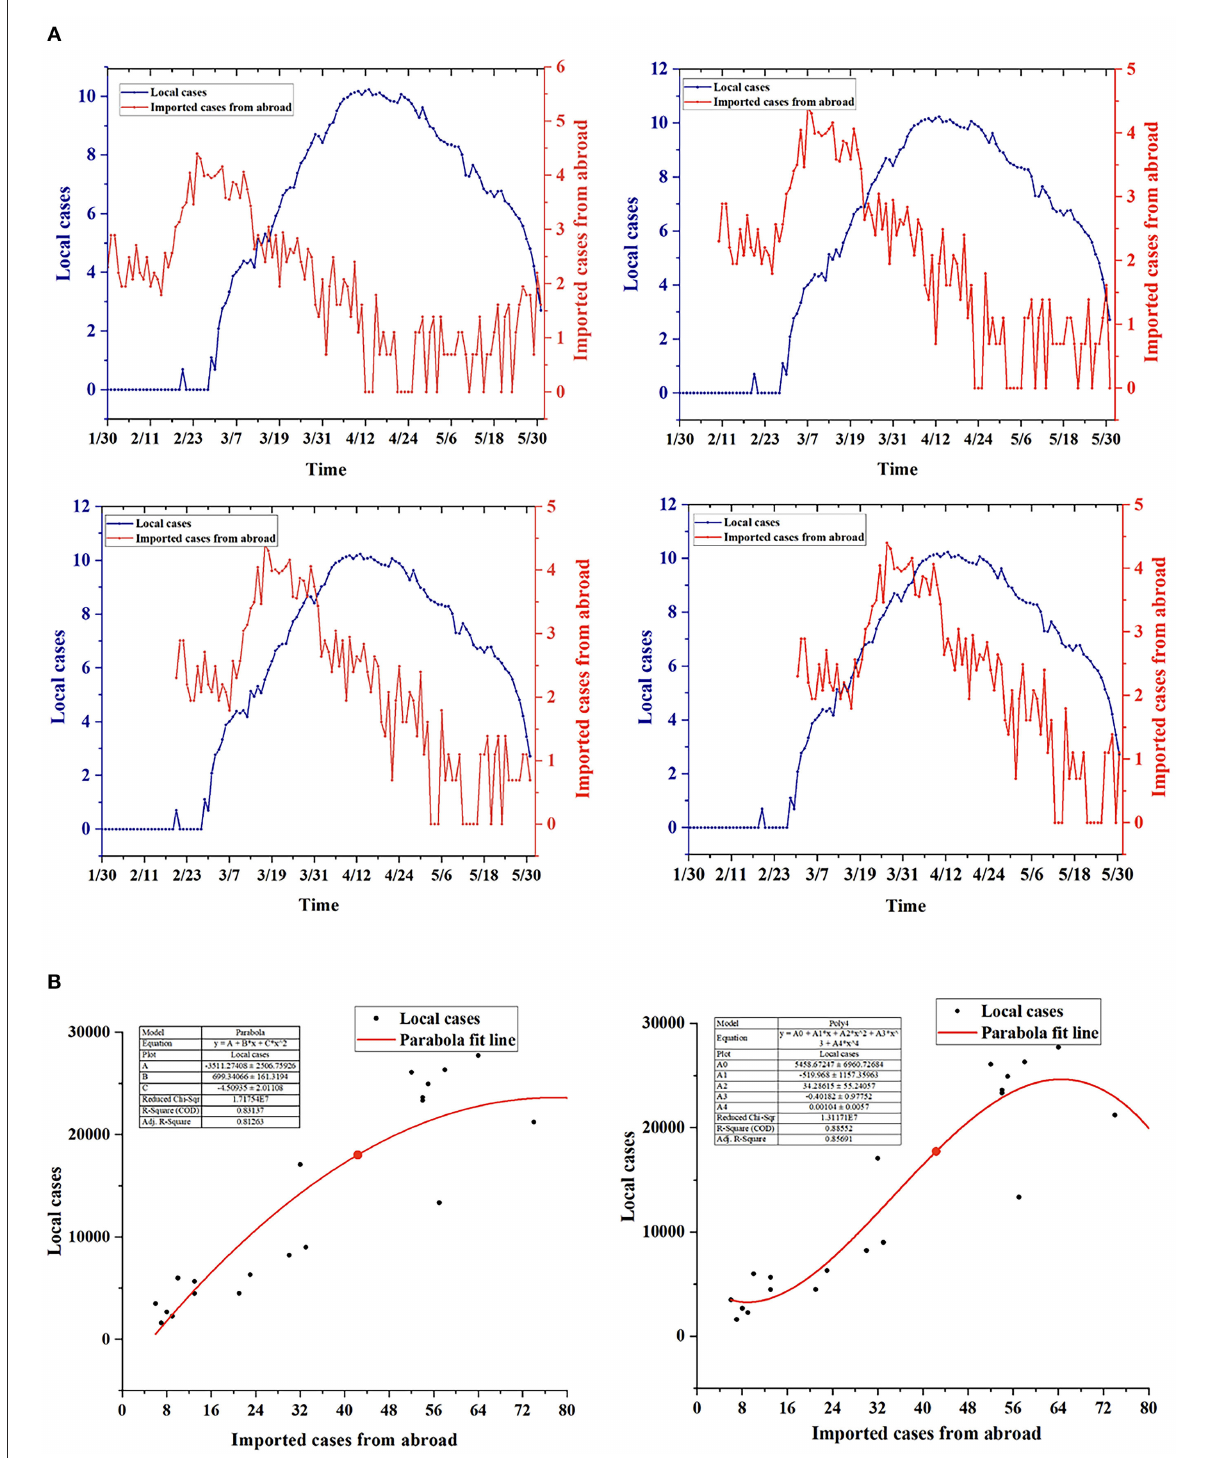
FIGURE5 Correlation analysis between local cases and imported cases. (A) Time lag analysis of the change trend between local cases and imported cases: There was a large difference in the magnitude of factors. Natural logarithm processing was applied to local and imported cases. Based on the time of imported cases, the order was as follows: January 30, February 10, February 20 and March 2. (B) Correlation analysis between local cases and imported cases: The included local cases ranged from March 24 to April 13, and the imported cases ranged from February 11 to March